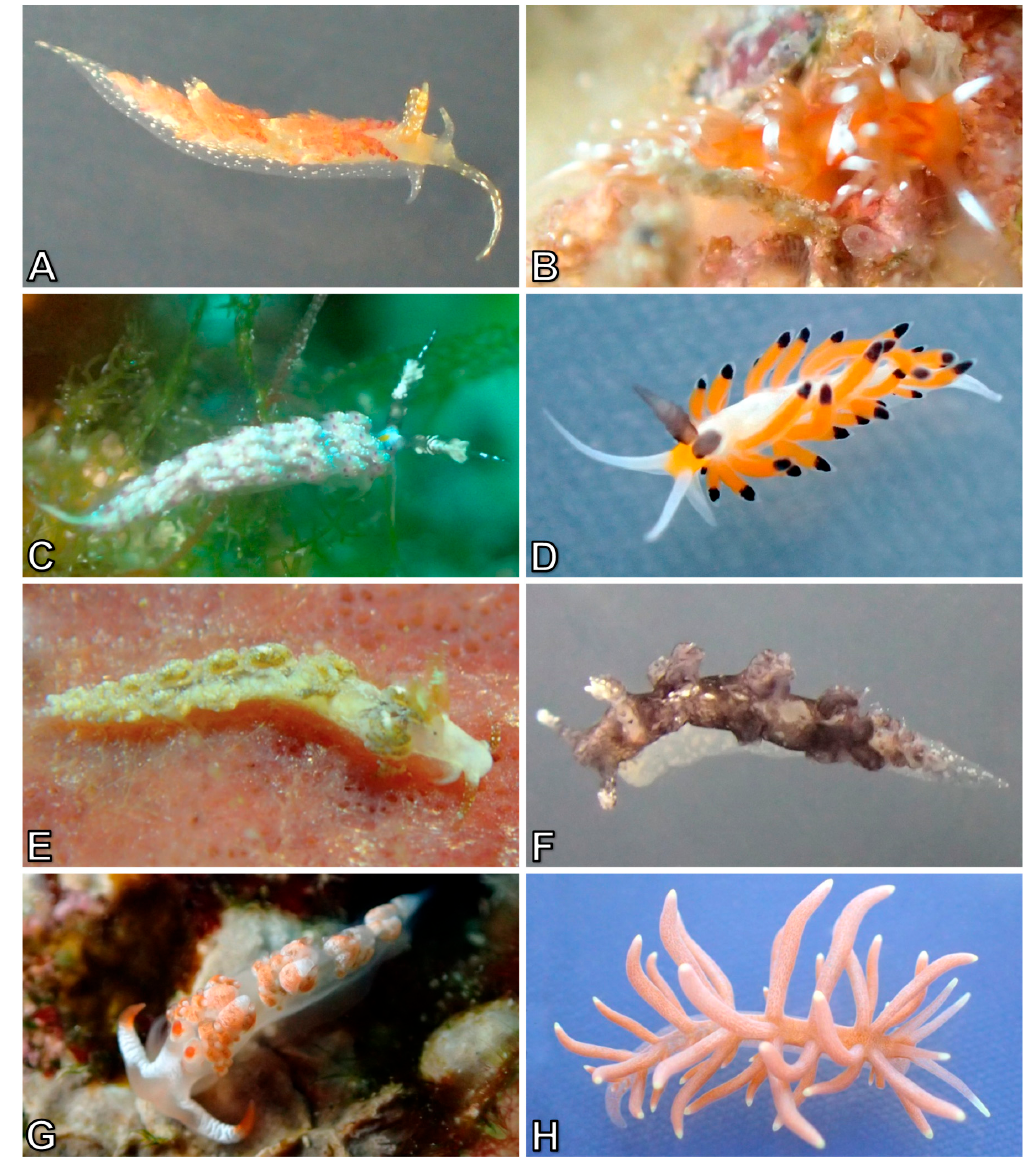
Figure 15. Nudibranchia - Cladobranchia: ( A ) Facelina spec. ( Facelina sp. 4 in Gosliner et al. [11]: 359), Fasp3_16Bu-2; ( B ) Facelina spec. ( Facelina sp. 8 in Gosliner et al. [11]: 360), Fasp8_16Bu-1; ( C ) Favorinus mirabilis ; ( D ) Favorinus tsuruganus ; ( E ) Noumeaella spec. ( Noumeaella sp. 3 in Gosliner et al. [11]: 367), Nosp13_16Bu-1; ( F ) Noumeaella spec. ( Noumeaella sp. 12 in Gosliner et al. [11]: 367), Nosp12_16Bu-1; ( G ) Noumeaella spec., Nosp2_16Bu-1; ( H ) Phyllodesmium briareum . Diversity 2018 , 10 , x FOR PEER REVIEW